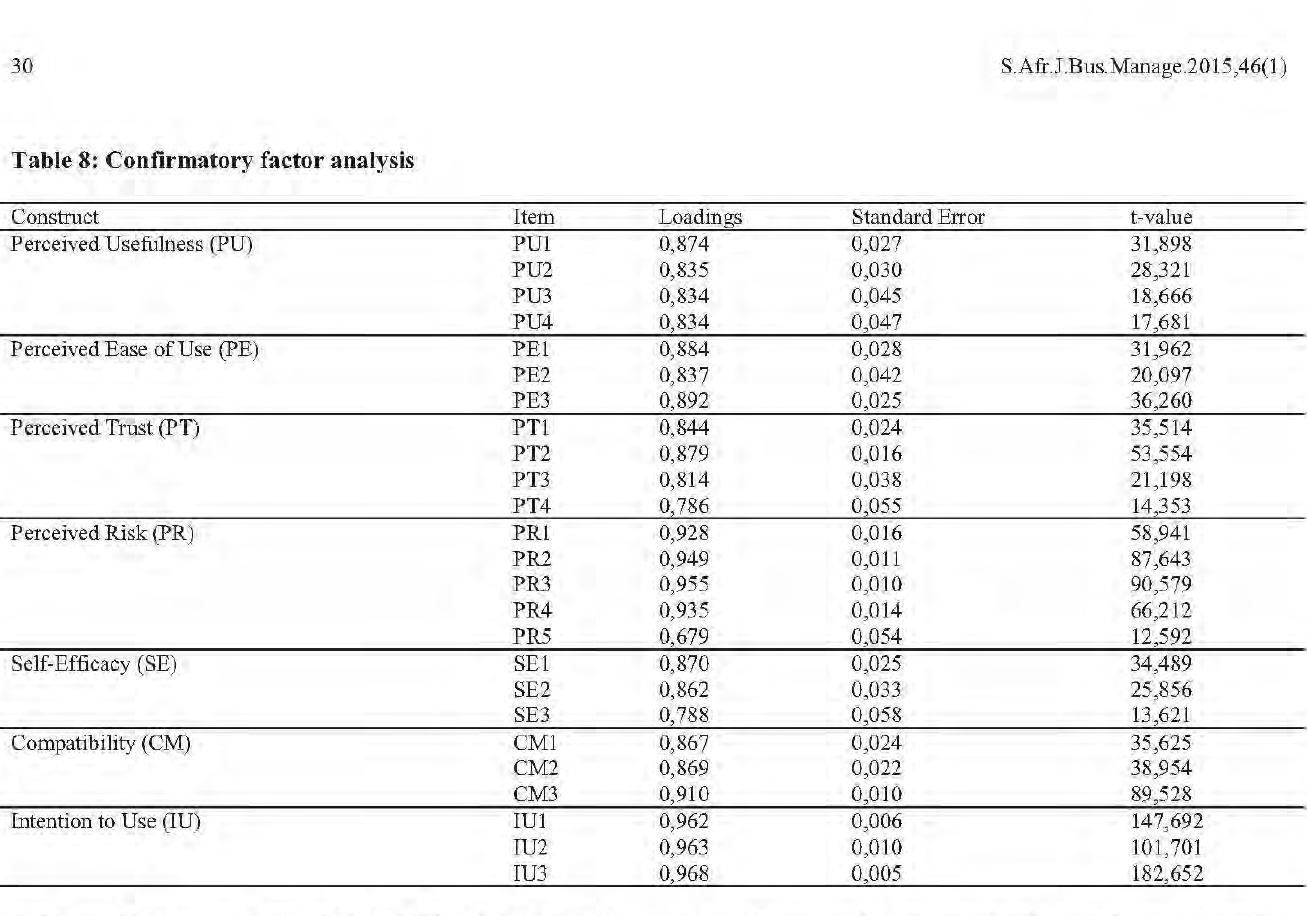
Table 9: Construct correlation coefficients and square